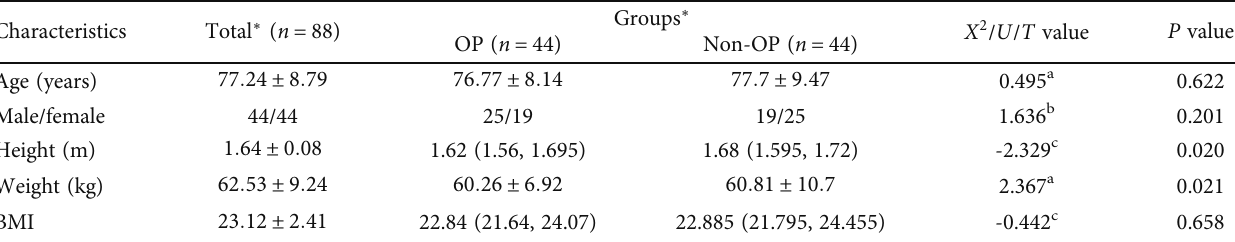
Table 1: Clinical characteristics of the participants in this